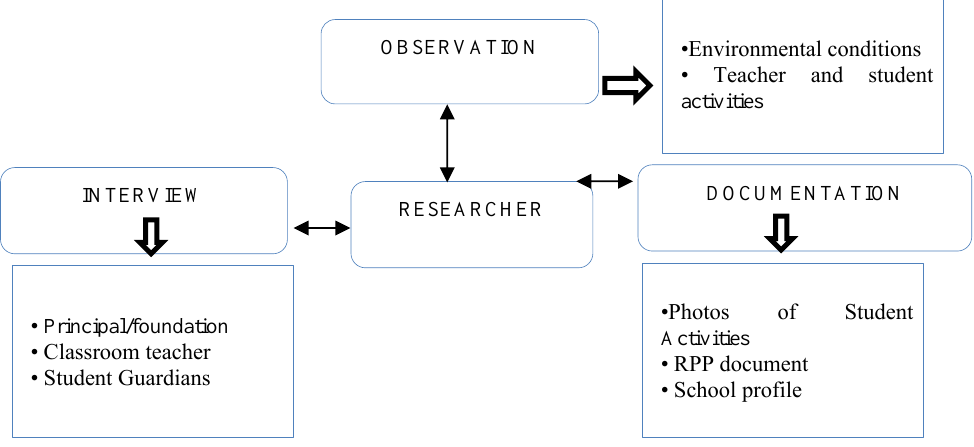
Figure 1: Triangulation with three data collection